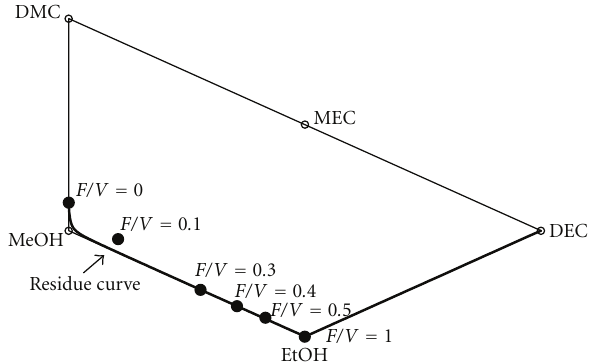
Figure 4: Shifting of the stable node of the extractive profiles at total reflux.